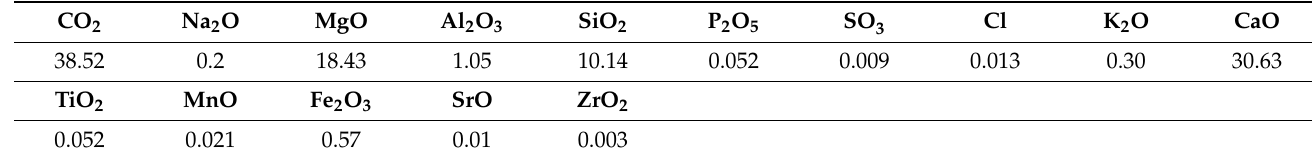
Table 2. Chemical composition of